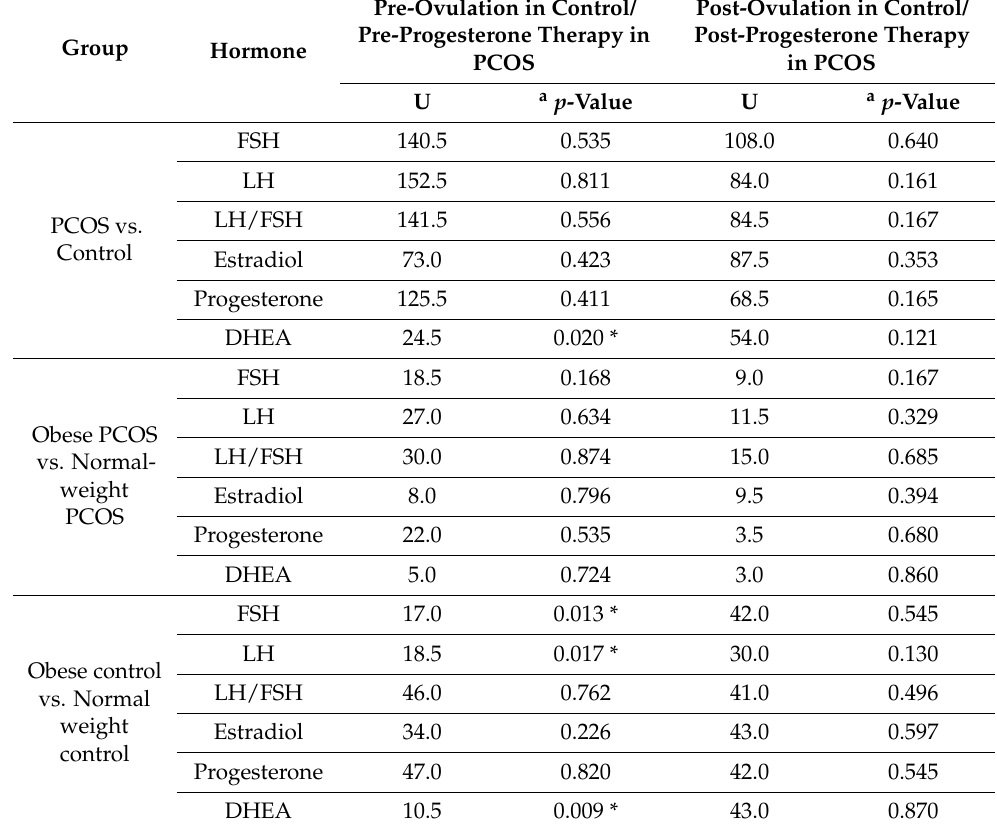
Table 3. Comparison of hormones level between study groups. Post-Ovulation in Control/ Pre-Ovulation in Control/ Post-Progesterone Therapy Pre-Progesterone Therapy in Group Hormone in PCOS PCOS U a p -Value U a p -Value FSH 140.5 0.535 108.0 0.640 LH PCOS vs. Control